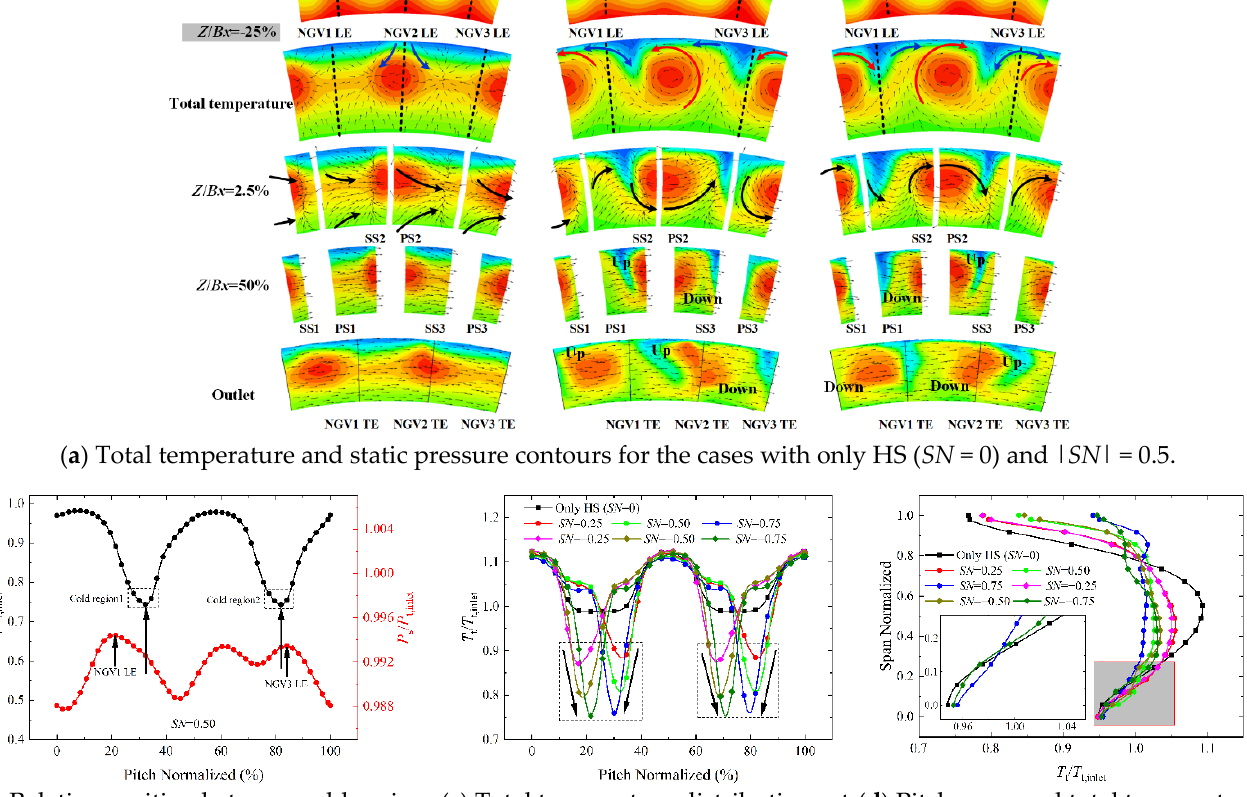
Figure 19. Hot and cold fluid migrations under the effect of the